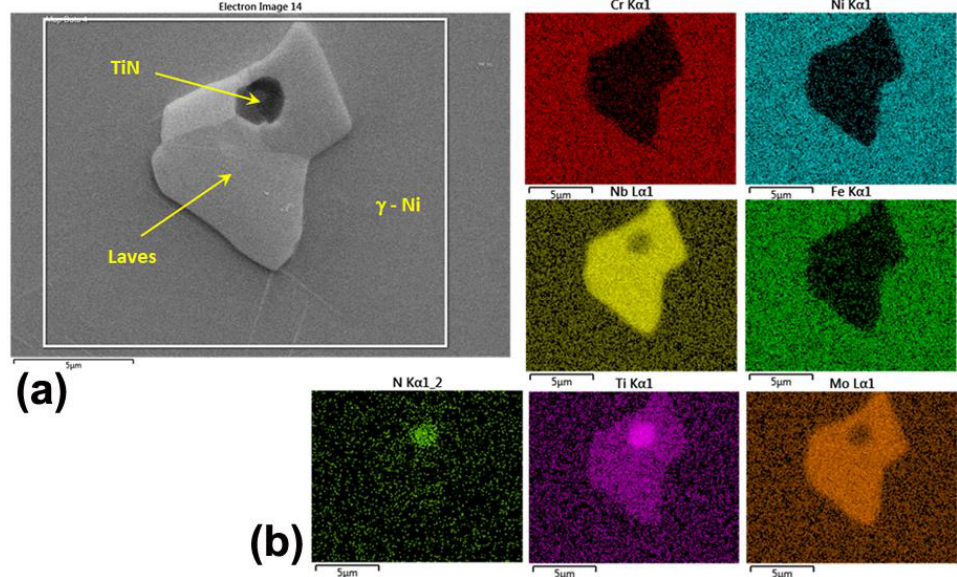
Figure 14. FESEM micrograph for IN718 alloy obtained by investment casting. ( a ): with modified heat treatment—TT1 (polished samples, SE mode), and ( b ): the respective X-ray elemental maps through EDS.